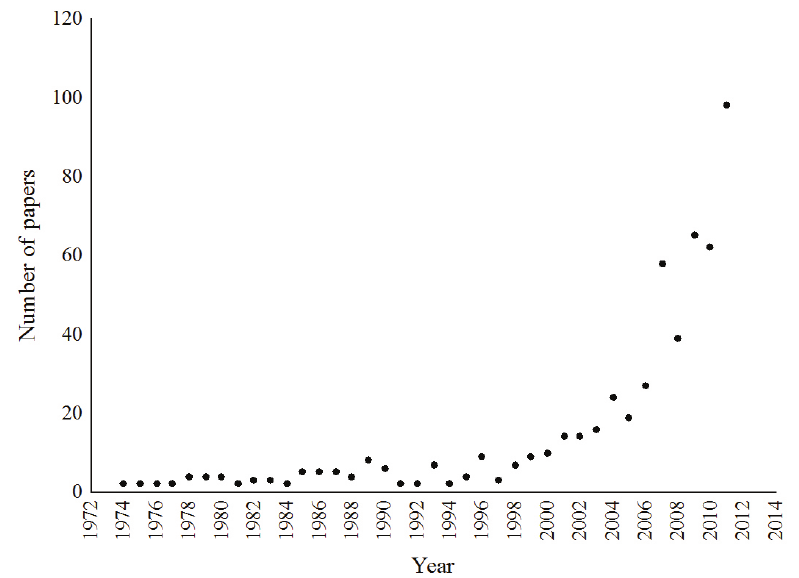
Figure 1. Temporal trend in the number of papers that contained the words ‘‘Water* qualit* index*” in the Scopus